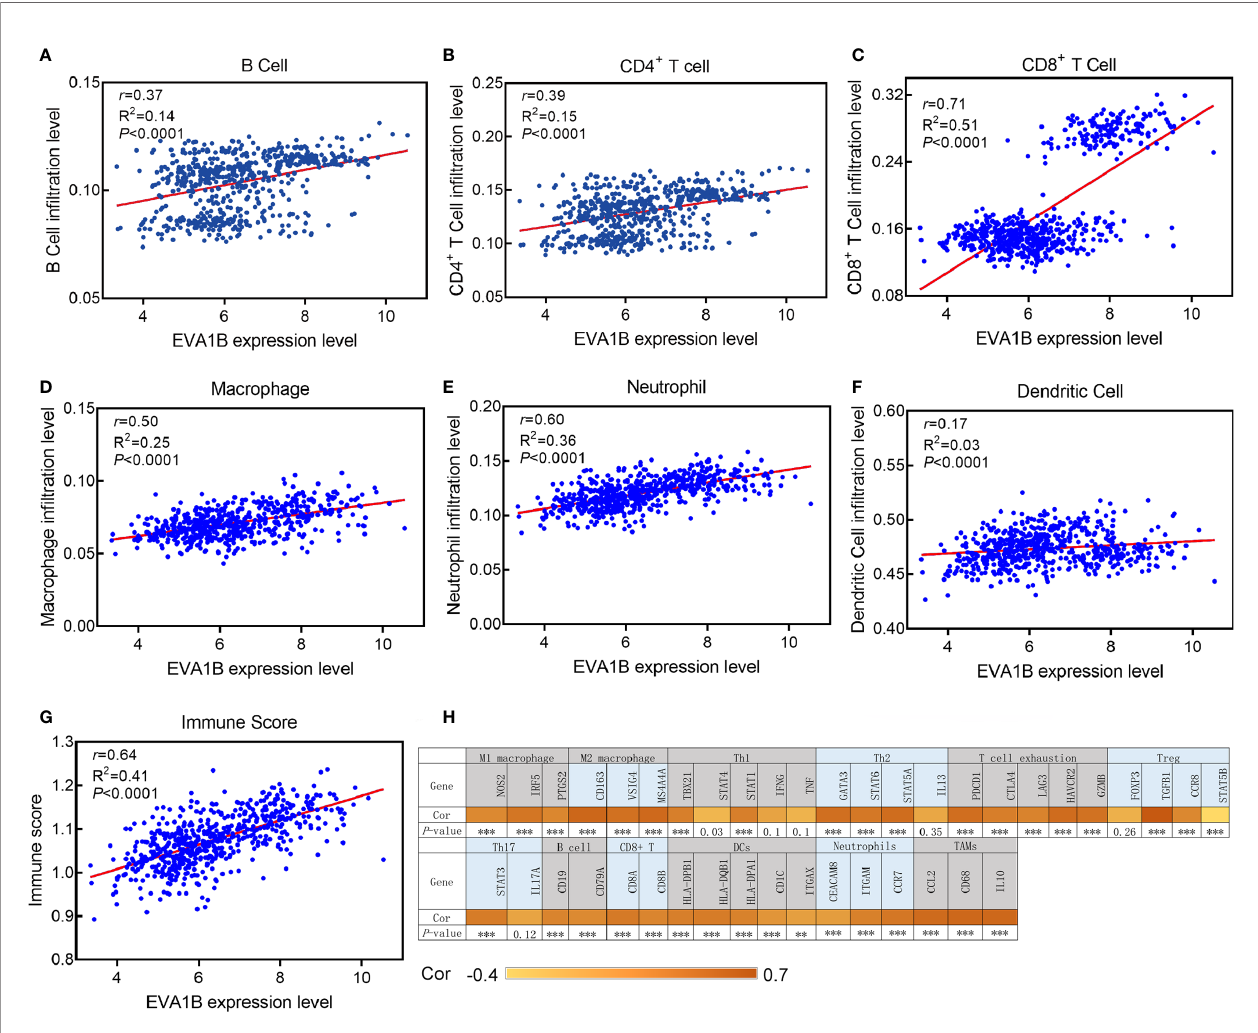
FIGURE 6 | The association between EVA1B expression and immune in fi ltration level. (A – F) EVA1B expression is correlated with in fi ltration levels of B cells, CD4 + T cells, CD8 + T cells, macrophages, neutrophils, but very weakly or not correlated with DCs. (G) EVA1B expression is strongly correlated with the overall immune score of glioma. (H) Heatmap showing the correlation between EVA1B expression and the immune markers of various immune